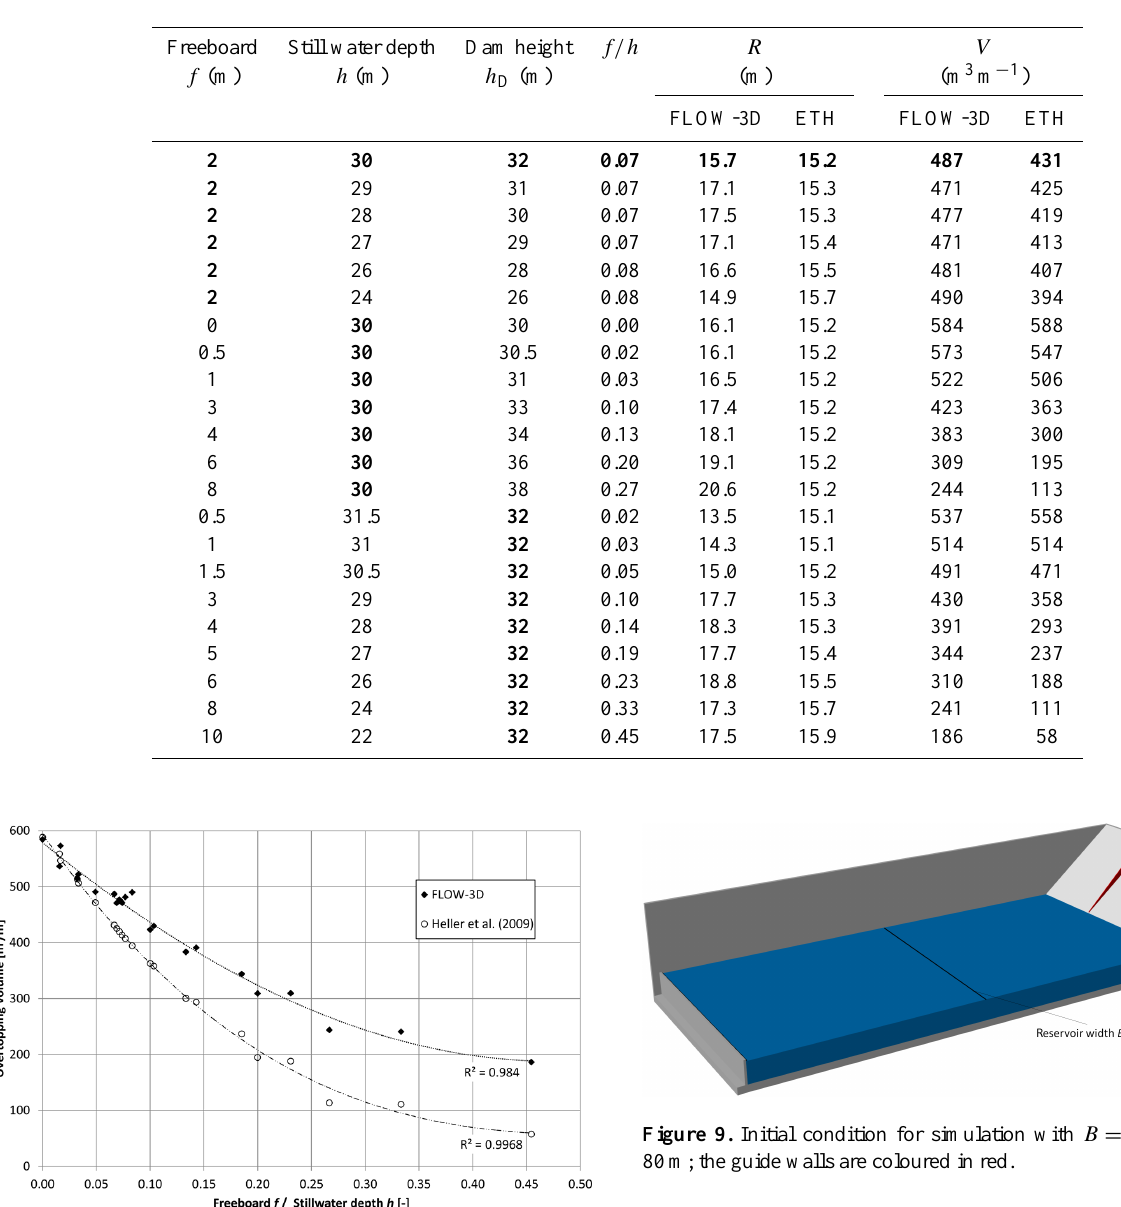
Table 2. Input parameters for the variation and the results (run-up height R and overtopping volume V ) for both modelling concepts; values similar to the reference geometry are in bold.